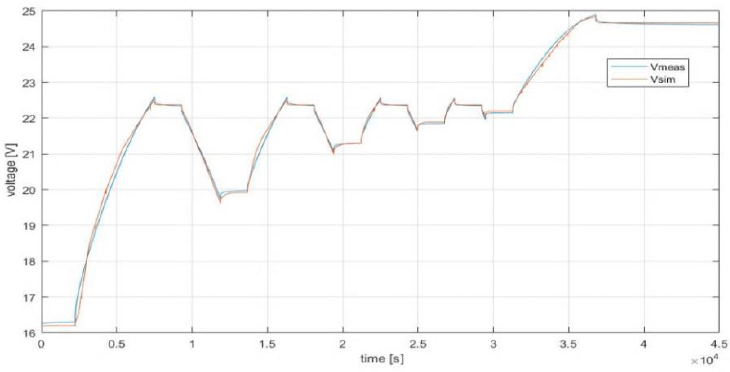
Figure 17. Results with hysteresis modeling.